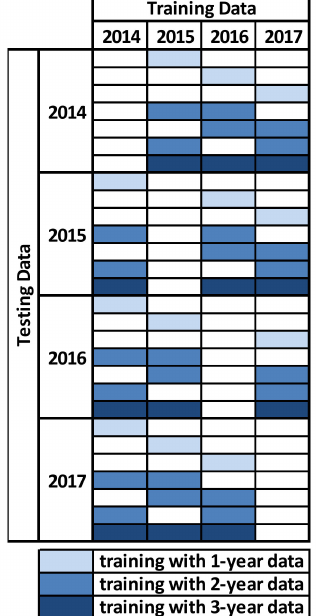
Figure 10. Data setups used for the simulations, considering di ff erent training data (from 1 to 3 years in several combinations) for each one-year simulation, represented as the testing